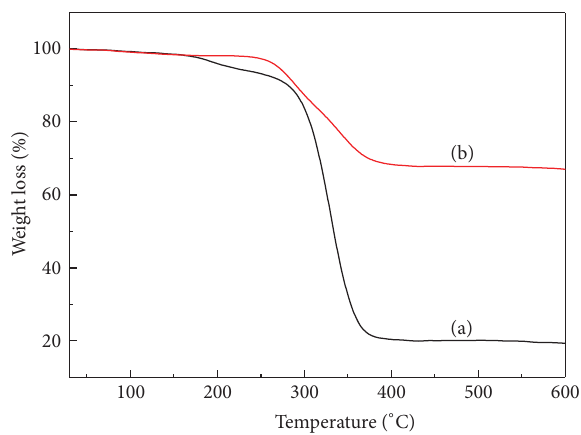
Figure 6: TGA curves of (a) Fe(OH) 3 @PMMA composite microspheres and (b) magnetic microspheres.